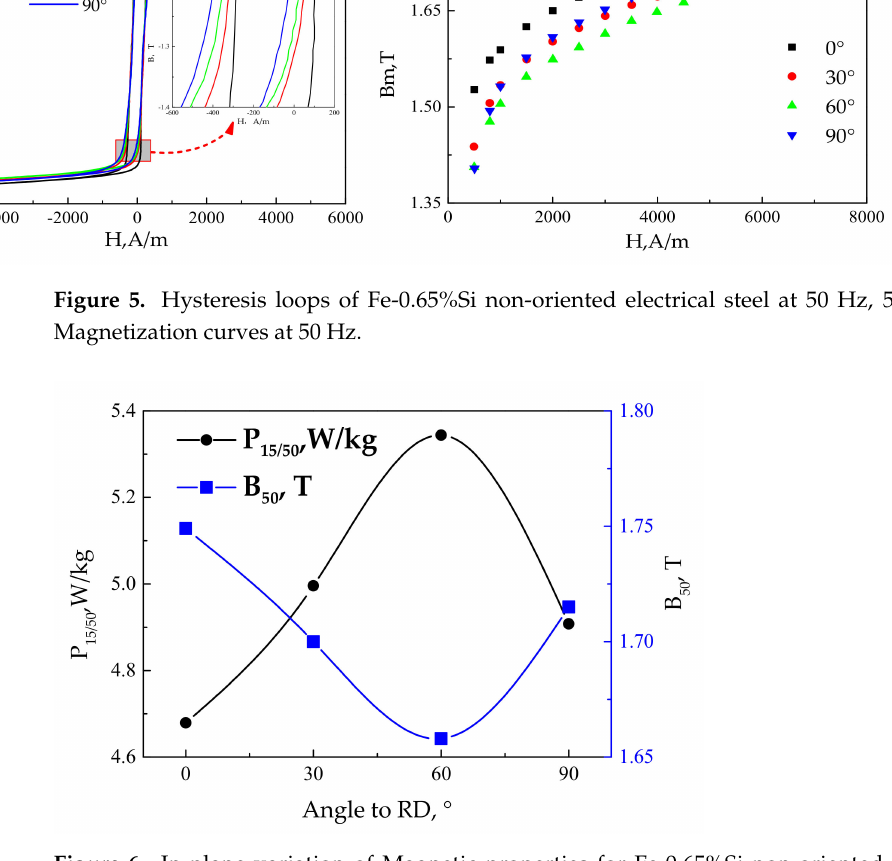
Figure 6. In-plane variation of Magnetic properties for Fe-0.65%Si non-oriented electrical steel annealed